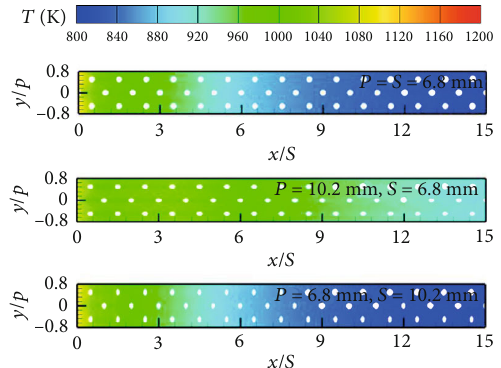
Figure 21: Temperature distribution on the hot-side surface at di ff erent hole arrangements.